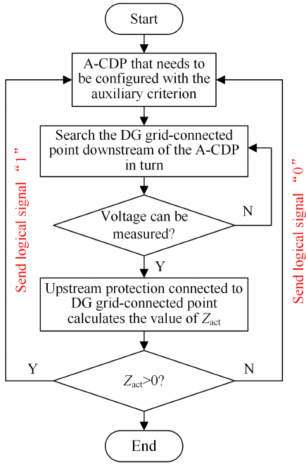
Figure 11. Configuration process of the auxiliary